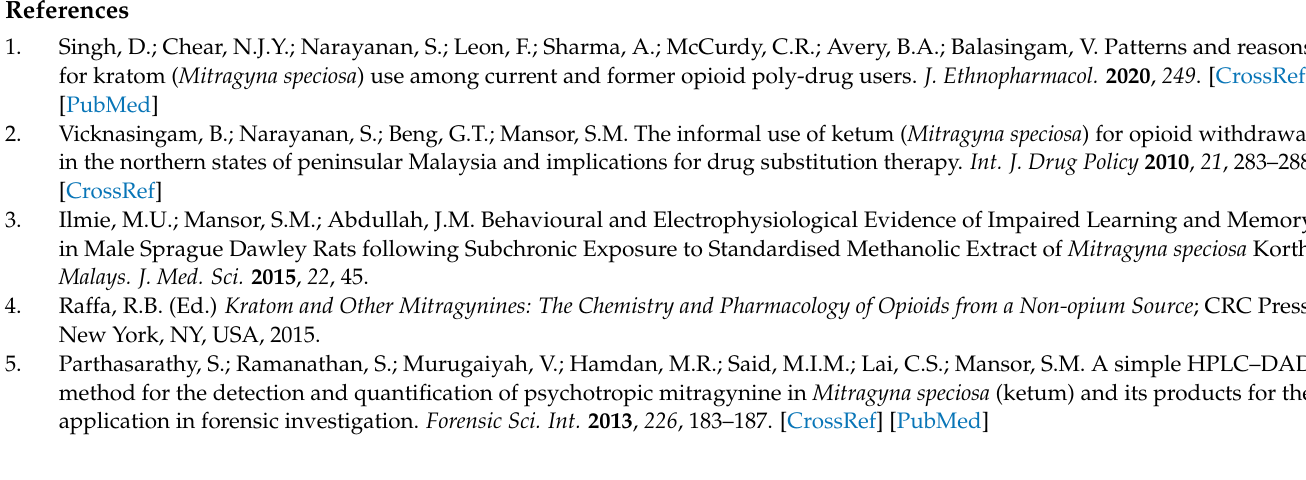
Table S5: 1H-NMR (700 MHz) and 13C-NMR (175 MHz) in acetone-d6 for